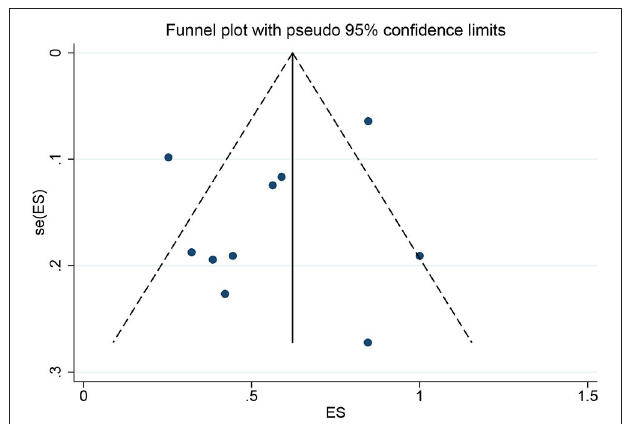
FIGURE 2 | Funnel plot for the proportion of abnormal neuroimaging finding in patients who exhibited neurological manifestation and underwent brain CT or